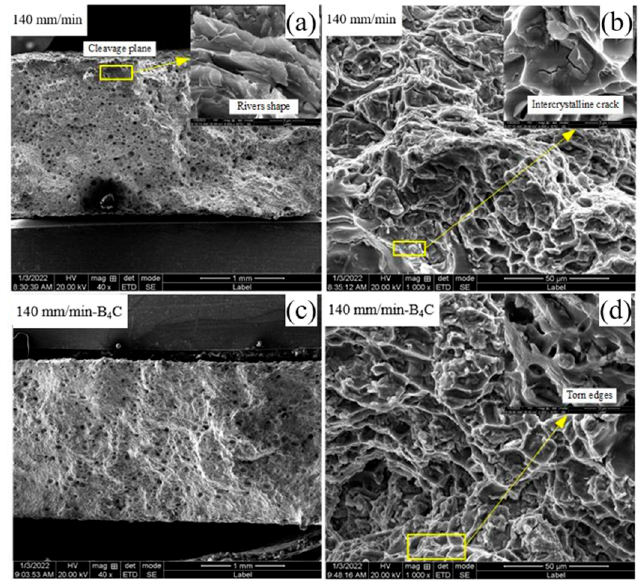
Figure 15. Fracture profile of deposited aluminum alloy tensile specimens in longitudinal direction. ( a , b ) 140 mm/min, ( c , d ) 140 mm/min-B 4 C.